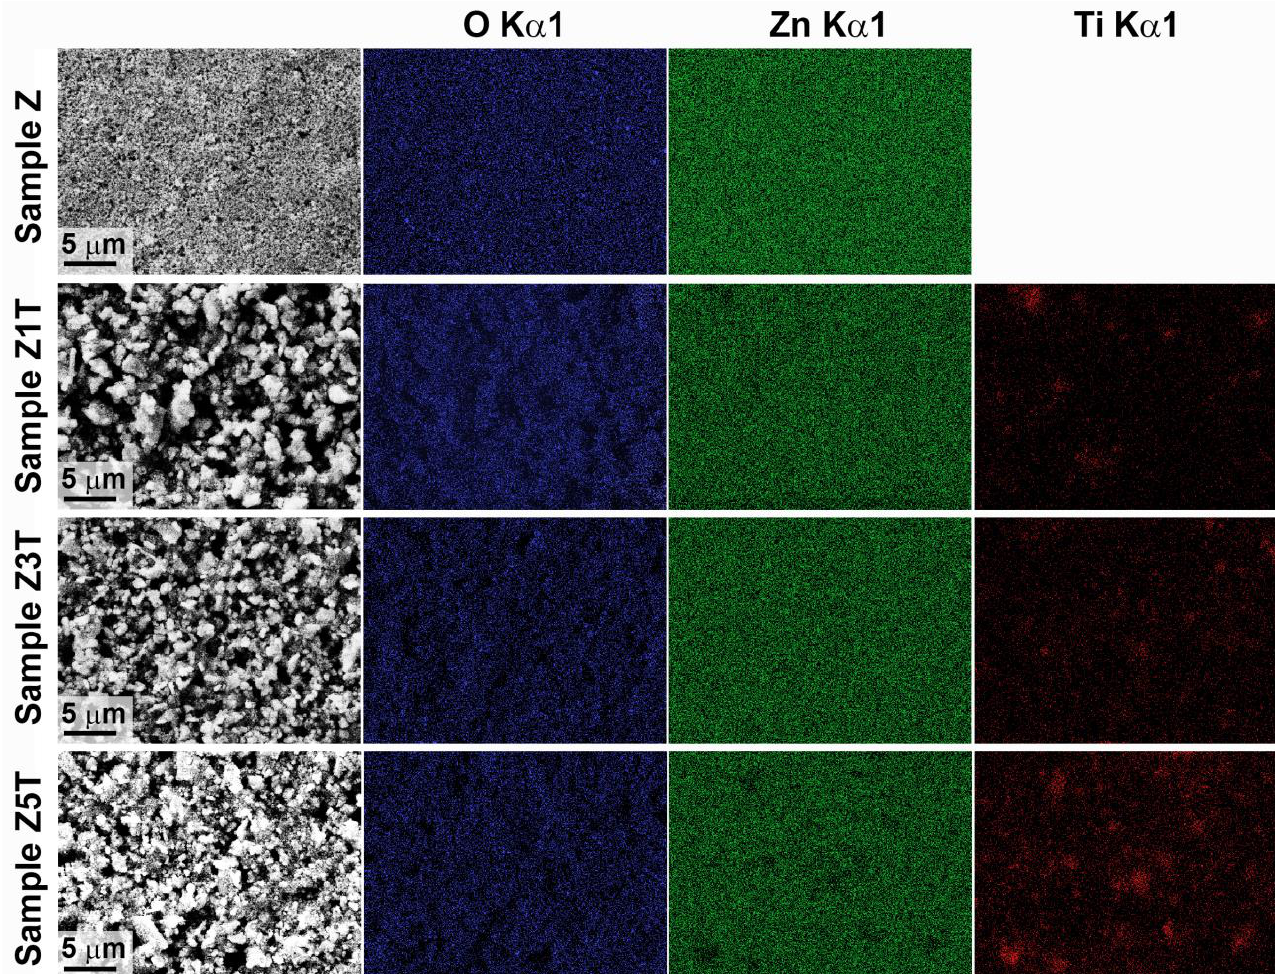
Figure 7. Distribution of elements O, Zn and Ti obtained by EDX mapping for coating samples Z, Z1T, Z3T and Z5T.